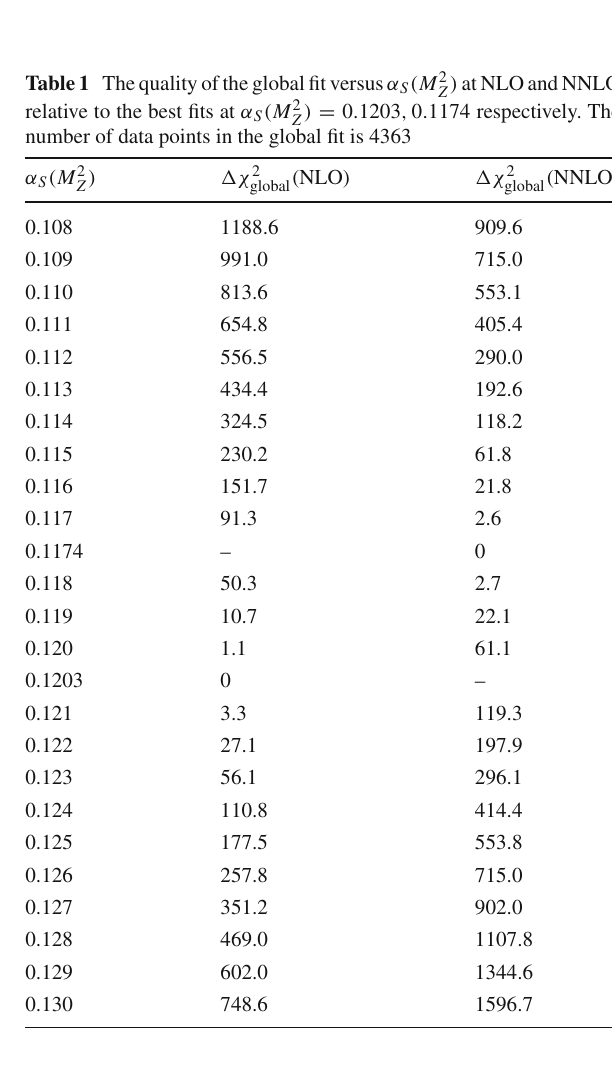
Fig. 1 The left and right plots show total χ 2 as a function of the value of the parameter α S ( M 2 fits, respectively